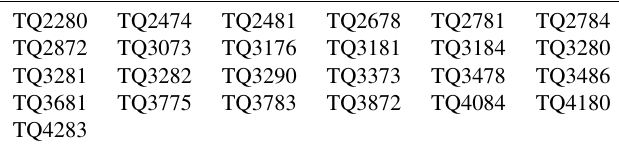
Table A2. Grid references of hand-labelled areas. Grid references are in the OSGB 1936